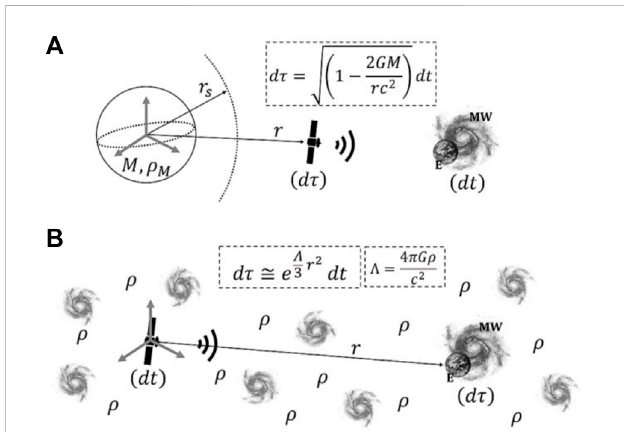
FIGURE 1 Schematic representation of the comparison between the Schwarzschild solution (A) and the solution of EFE through a FLRWT metric framework (B) , both in terms of time dilation. r is the radial distance, τ is the proper time, t is the cosmic time, r s is the Schwarzschild radius, MW denotes the Milky Way, and E is the Earth. Moreover,Misthemassofthecompactobject,and ρ M isitsrelatedmass density, whereas ρ alone refers to the average mass density of the Universe. The distortion of the spacetime fabric determines, in both cases, a time dilation effect. In the fi rst case, (A) the closer the emitter is to the compact object, the higher the time dilation is and accordingly, the redshift measured at the receiver; in the second case, (B) the deformationofthespacetimefabricoccursduetotheaveragedensityof matter ρ . Photons of light travel through this distorted spacetime, causing a time dilation and, accordingly, a redshift. The greater the distance, the higher the redshift is The coordinate system is arbitrarily placed for convenience in the emitter: this step is allowed due to the hypothesis of homogeneity, isotropy, and fl at spacetime (supported by observations) applied to the whole